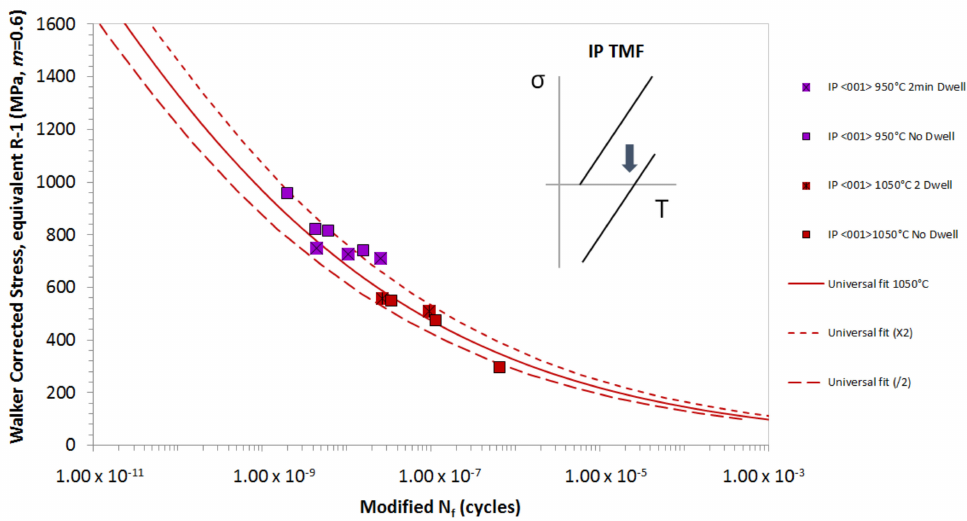
Figure 4. A thermo-mechanical fatigue (TMF) lifing model is applied to the IP TMF results for ∆ T = 450–950 ◦ C and ∆ T = 550–1050 ◦ C, not including the 2 min dwell period